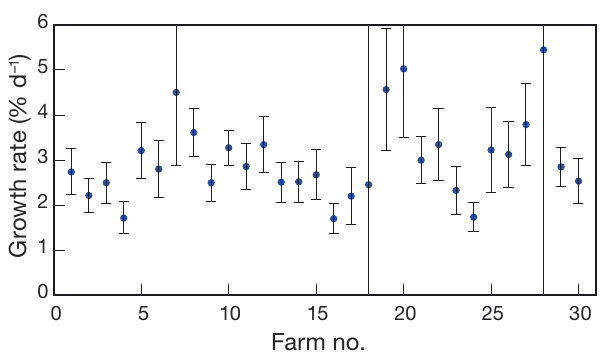
Fig. 5. Average salmon-louse population growth rate for each farm site in the Faroe Islands with 95%